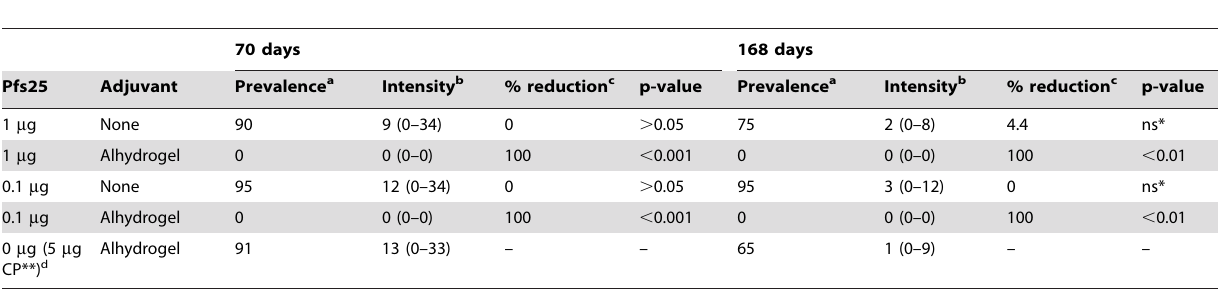
Table 1. Evaluation of TB activity in immunized mouse sera by SMFA: two vaccine doses.